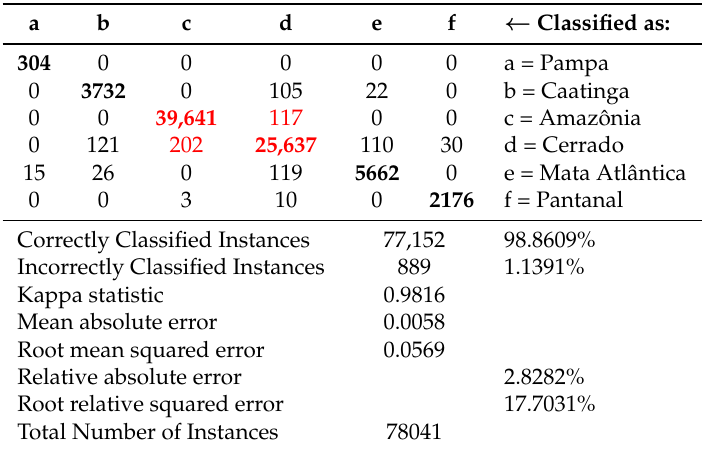
Table 1. Error Matrix of the classification per biome in the testing